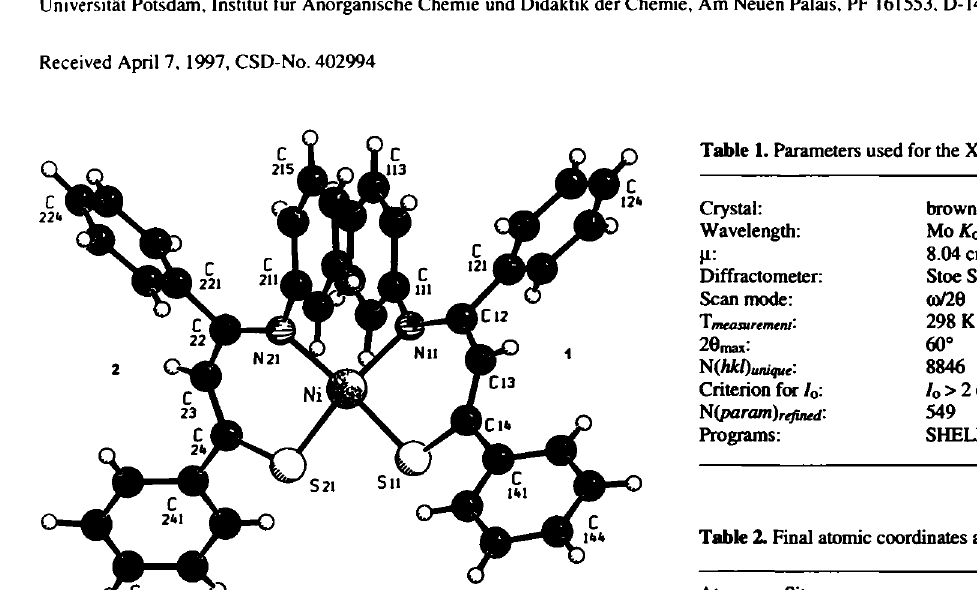
Tabk 2. Final atomic coordinates and displacement parameters (in